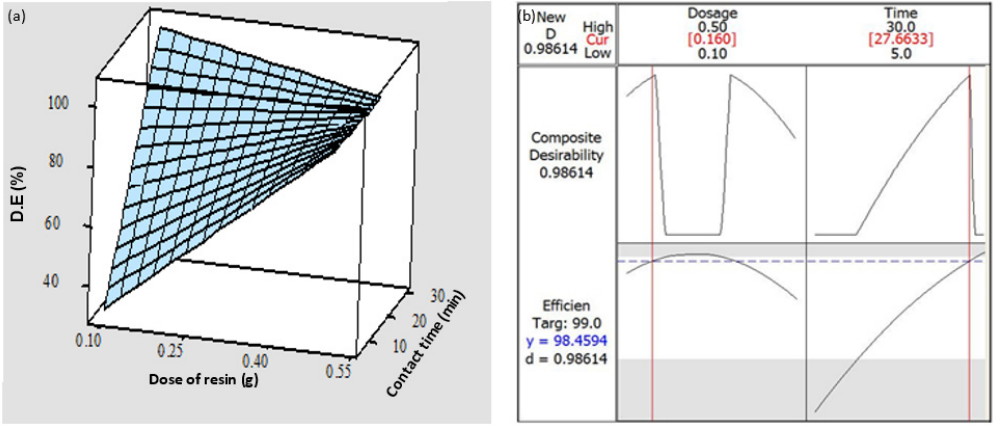
Figure 3. Surface plot showing the decolorization e ffi ciency (D.E. (%)) as a function of the dosage of resin (g) and contact time (min) under a shaking speed of 230 rpm and pH 3.6 ( a ), and optimization plot for the determination of the optimum conditions, namely dosage of resin (g) and contact time (min), for a maximum decolorization e ffi ciency (D.E. (%)) by SIR ( b